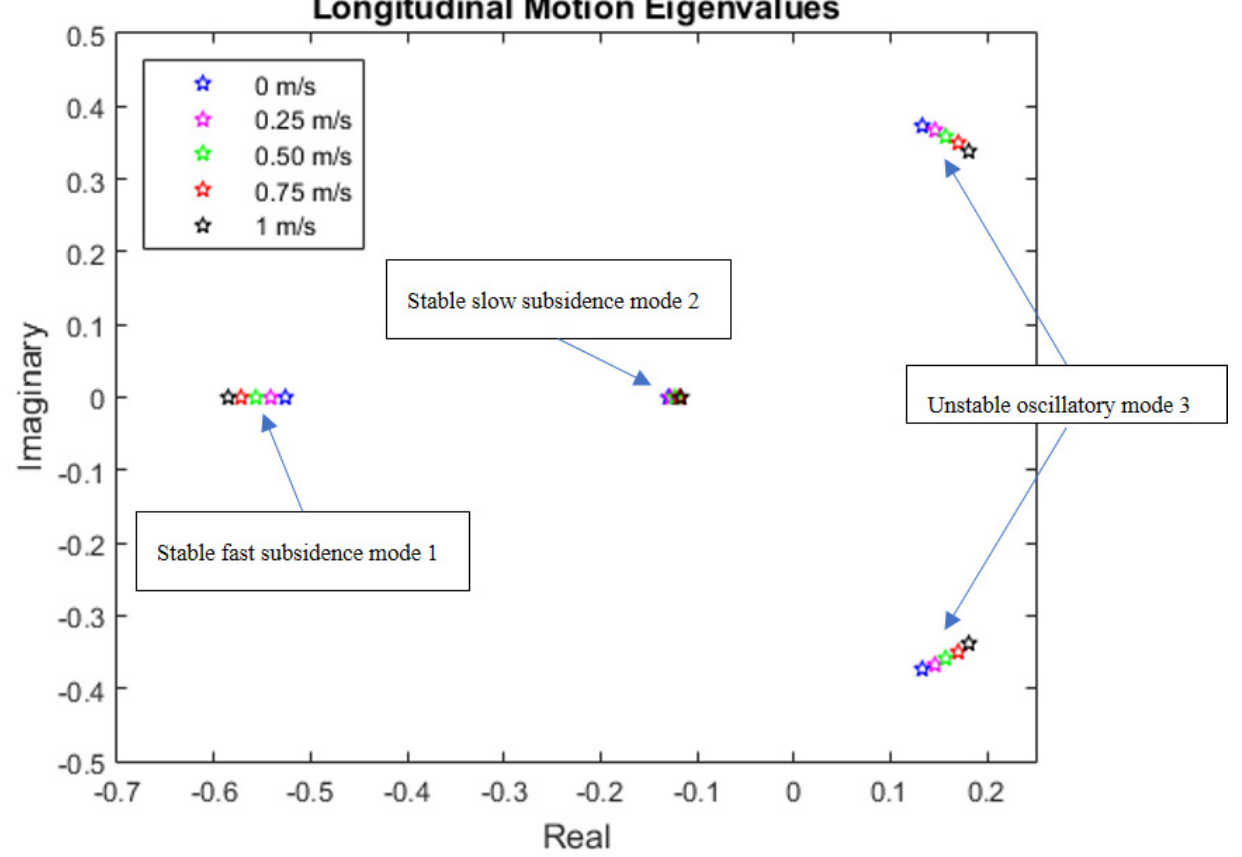
Figure 15. Nondimensionalized longitudinal dynamics eigenvalues at various flight speeds (hovering and forward flight).